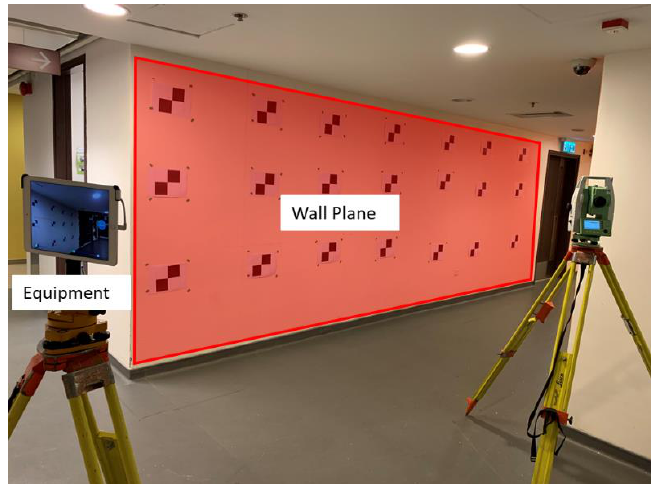
Figure 11. Test field and equipment setup for the second experiment.